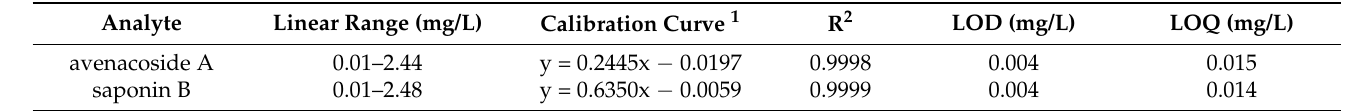
Table 2. The linear range, calibration curve, limits of detection (LODs), and limits of quantification (LOQs) of avenacoside A and saponin